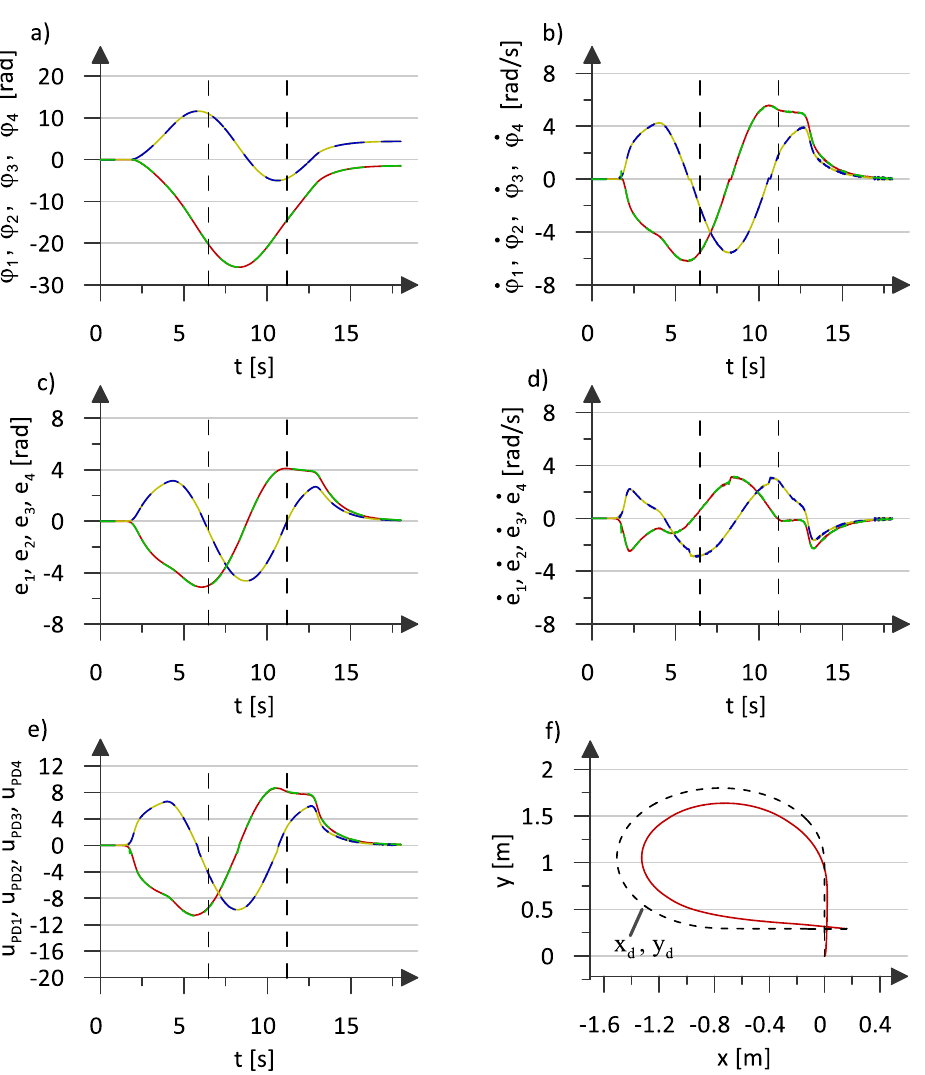
Figure 9. Results of verification 1: ( a ) waveforms of implemented rotation angles φ 1 , φ 2 , φ 3 , φ 4 , ( b ) angular velocities φ̇ 1 , φ̇ 2 , φ̇ 3 , φ̇ 4 , ( c ) tracking errors of the rotation angle e 1 , e 2 , e 3 , e 4 , ( d ) tracking errors of the angular velocity u PD1 , u PD2 , u PD3 , u PD4 , ( f ) graph of the desired (x d , y